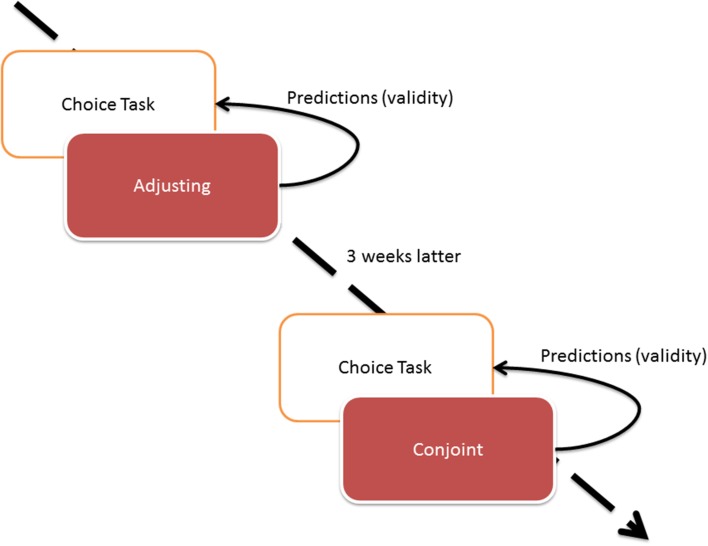
The Study 1 design.